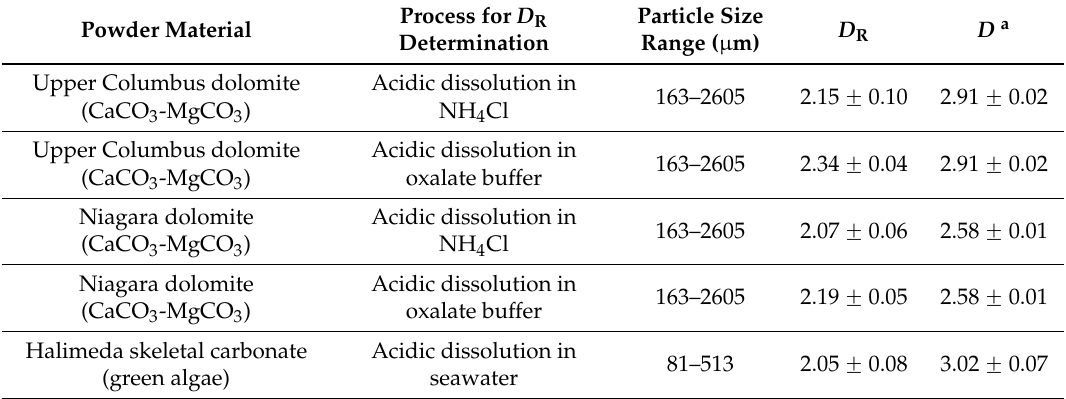
Table 1. Surface fractal dimensions and their standard deviations of natural powders in a shortened table taken from [7]. The D R is the reaction fractal dimension and D is the true fractal